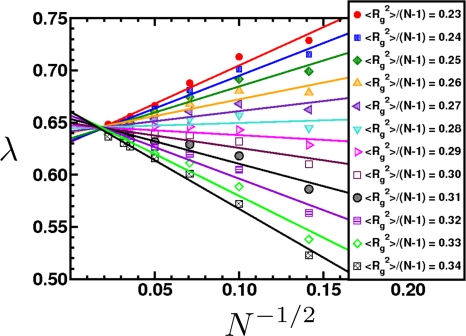
Interaction parameter λ of Equation (25) vs. N−1/2 for different values of the scaling function. Data points are based on the radius of gyration of linear chains [51].